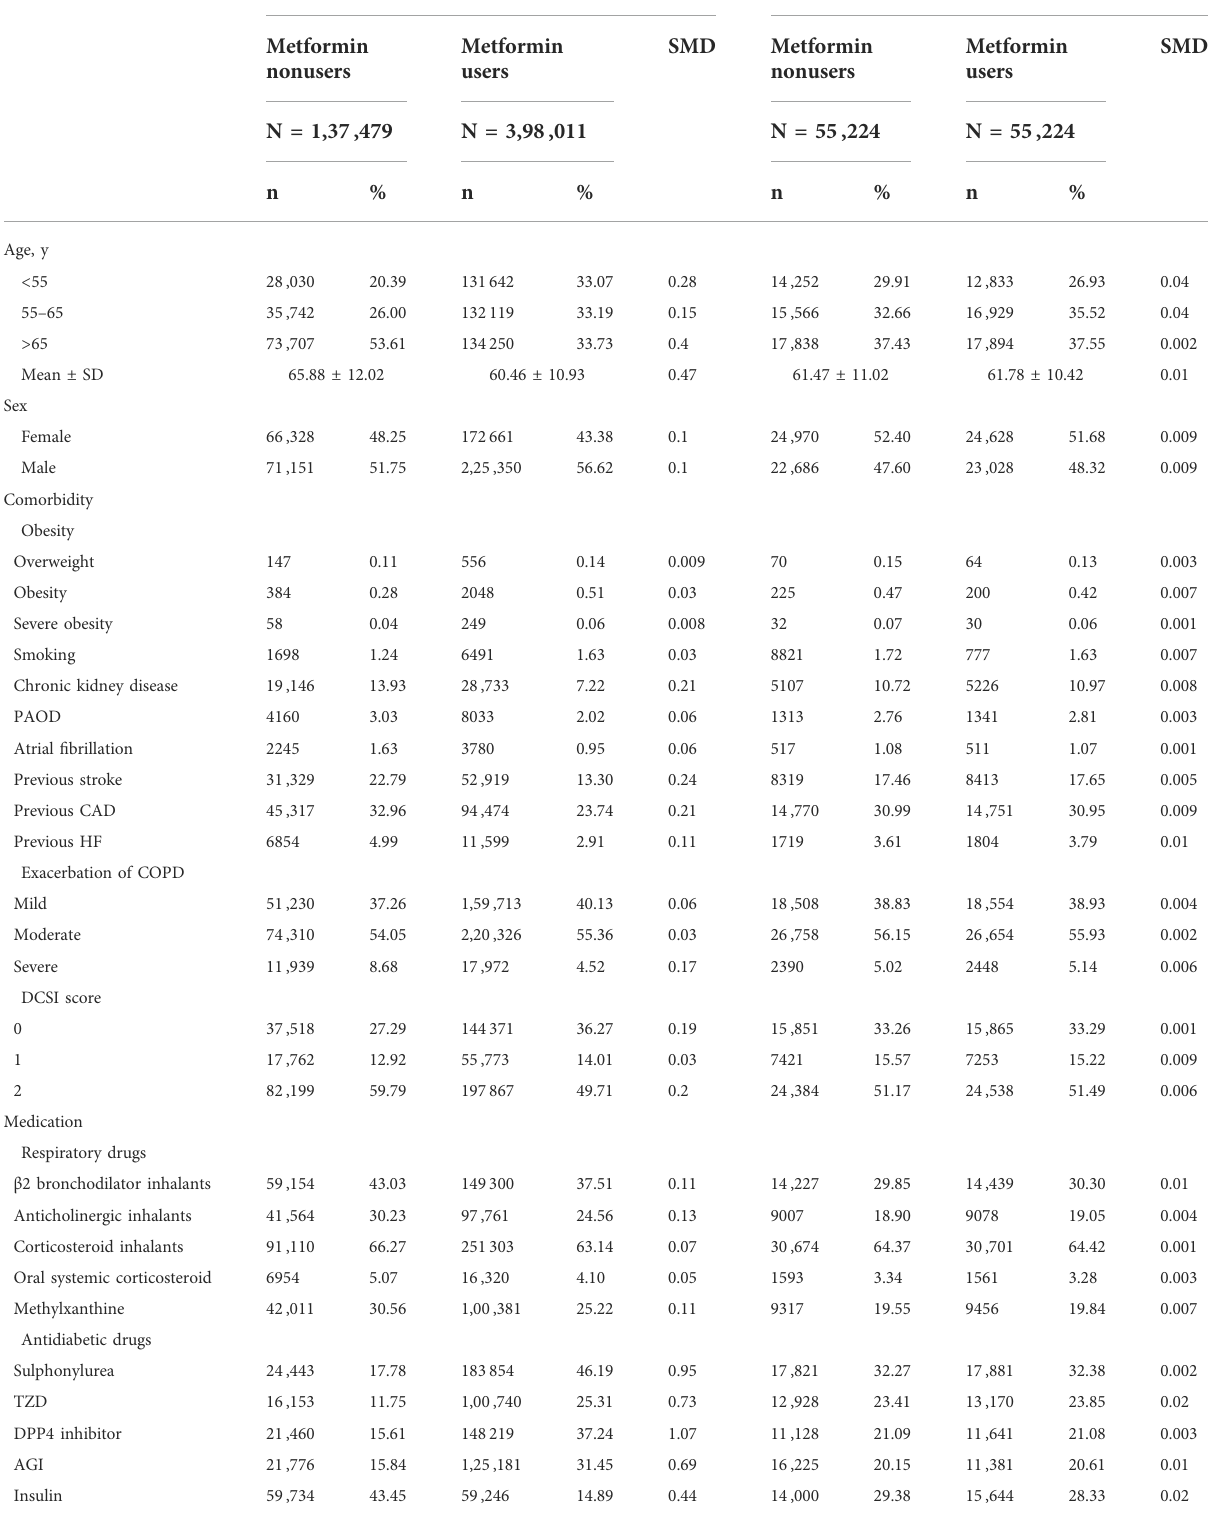
TABLE 1 Characteristics and medication use between metformin users and nonusers among patients with T2DM and COPD.